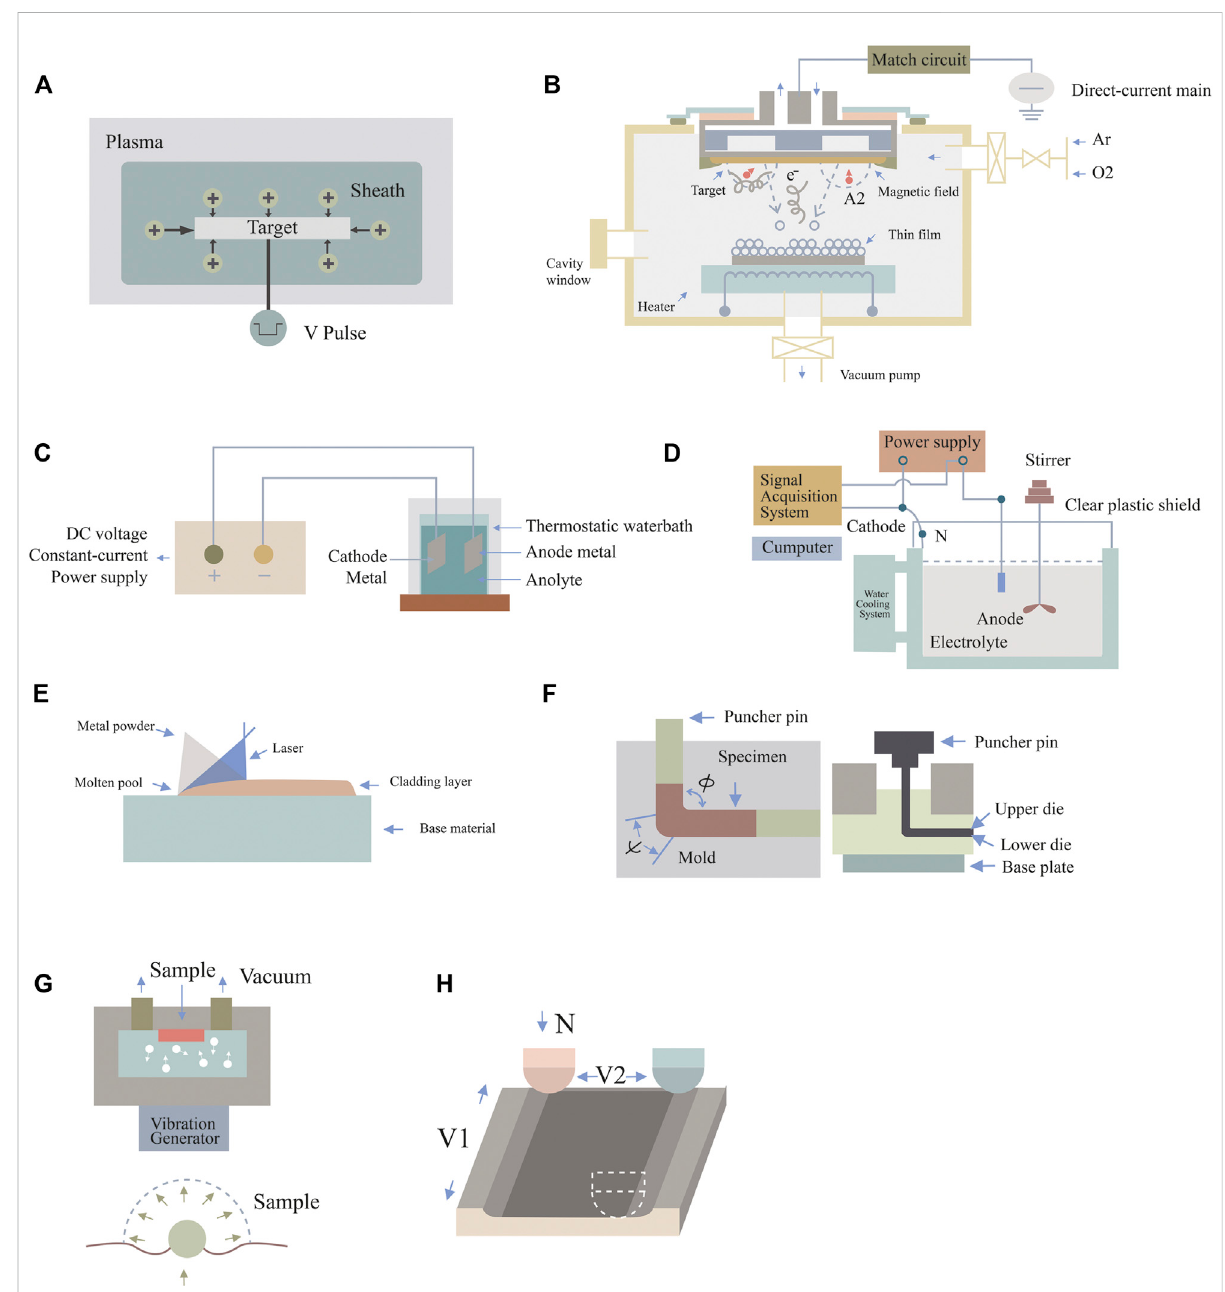
FIGURE 1 Schematic diagram of surface nanotechnologies. (A) Plasma immersion ion implantation, (B) DC magnetron sputtering technology, (C) anodic oxidation technique, (D) micro-arc oxidation technology, (E) laser cladding technology, (F) equal channel angular pressing, (G) surface mechanical attrition treatment, and (H) sliding friction